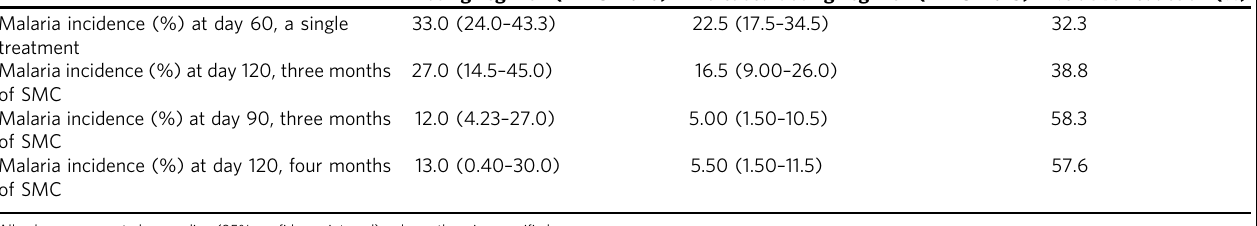
Table 3 Simulated malaria incidence in children given DHA-PQ seasonal malaria chemoprevention, following the WHO 2010 and 2015 dosing